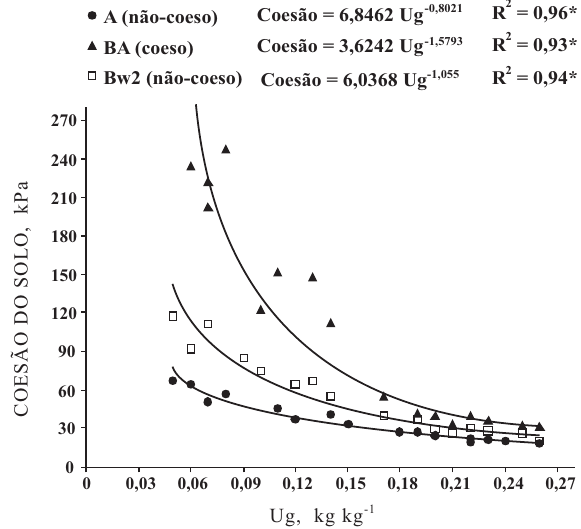
Coesão = 6,8462 Ug -0,8021